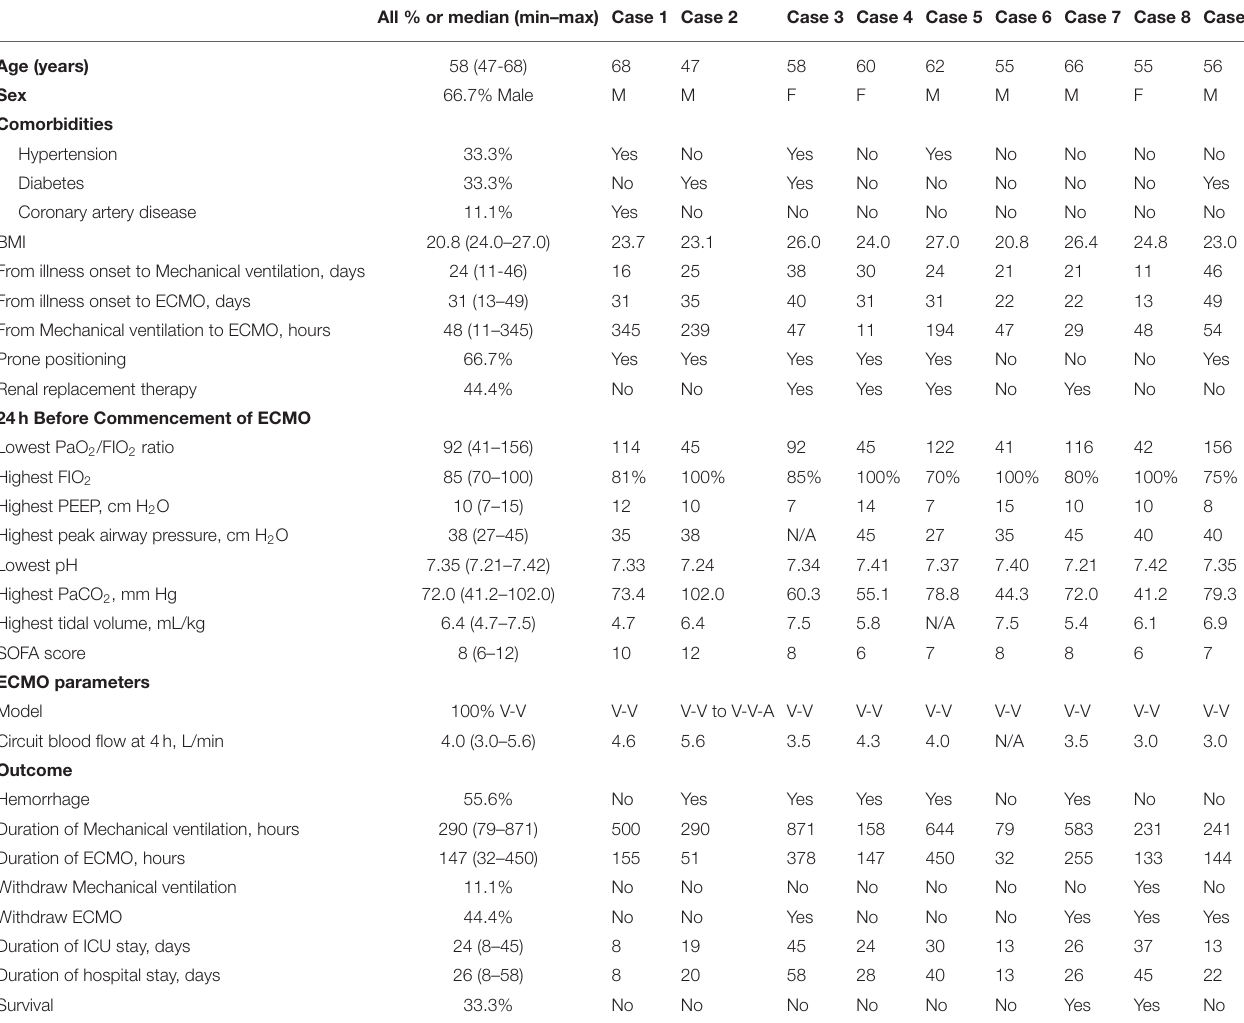
TABLE 1 | Characteristics and severity of ARDS and outcome of COVID-19 patients received ECMO *